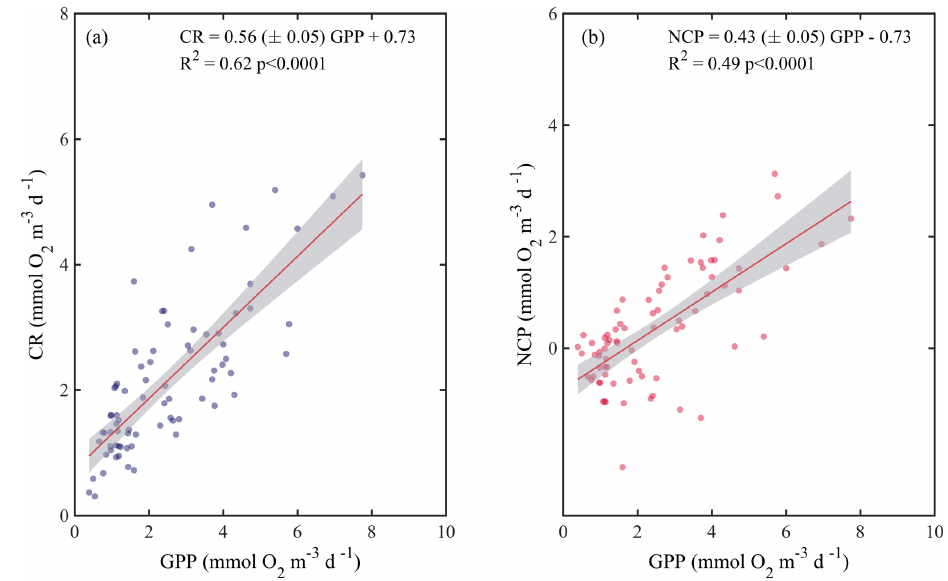
Figure 6. Ordinary least square linear regression between (a) planktonic community respiration and (b) net community production (NCP) with gross primary production (GPP) rates measured along the Red Sea. The ordinary least square regression parameters (slope and intercept) and the statistical significance of each regression are indicated. The solid red line represents the linear least square fit and the shaded grey area represents the 95% confidence